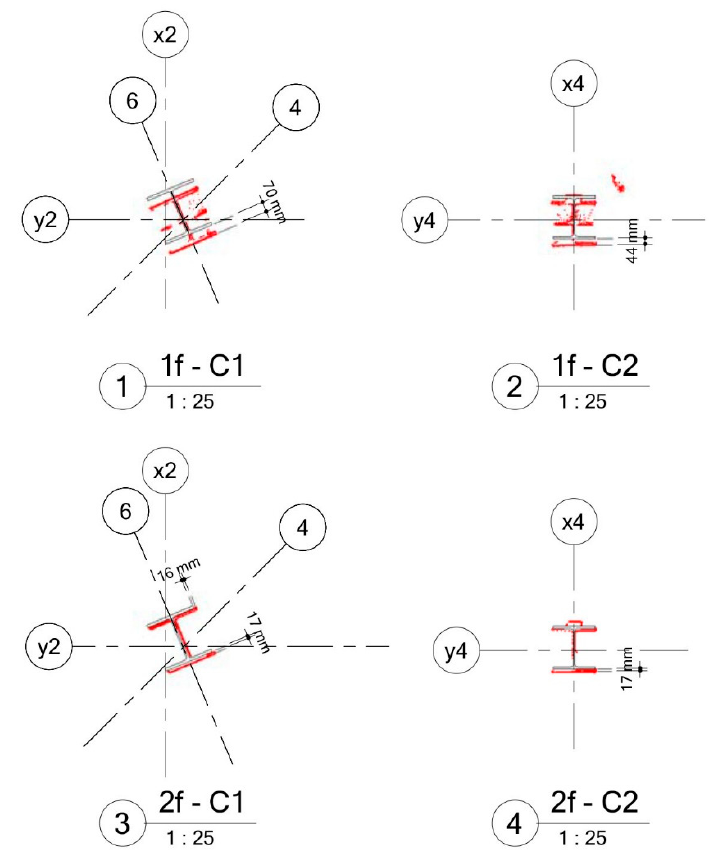
Figure 9. Column construction deviation.